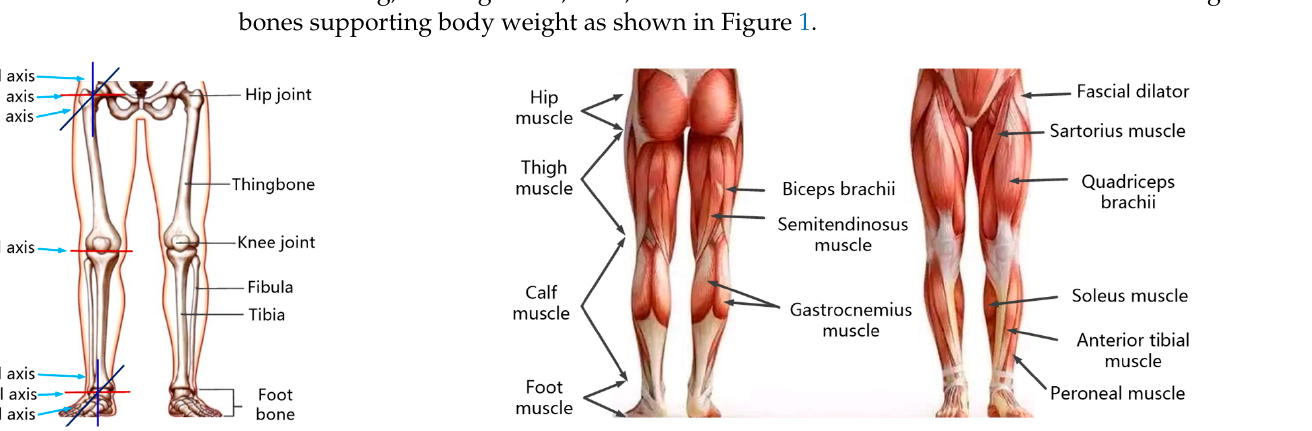
Figure 1. Bones, joints and muscle diagram of human lower limbs. The lower limb skeletal muscle consists of hip muscle, thigh muscle, calf muscle and foot muscle. The main function of the anterior group of hip muscles is to make the hip joint into flexion. The posterior group of the hip muscle mainly extends the hip joint and also plays the role of external rotating hip joint. The quadriceps femoris in the anterior group of thigh muscles is for extending the knee joint. Sartorius muscles can make hip and knee joints into flexion. The posterior group of thigh muscles includes biceps femoris, semitendinosus and so on. They have the function of extending the hip joint and flexing the knee joint. The function of the medial group of thigh muscles is to adduct the hip joint. The anterior group of calf muscles includes the anterior tibial muscle, extensor digitorum longus muscle and so on. They can flex the back of the foot. The posterior group of calf muscles includes gastrocnemius and soleus. The main function is to make foot plantar flex, as shown in Figure